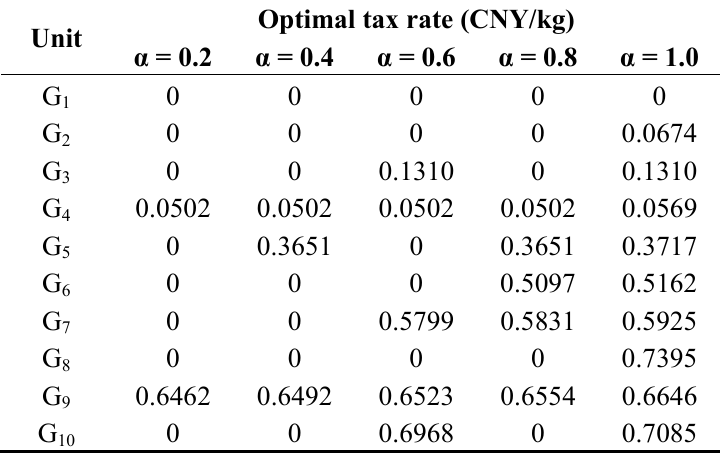
Table 4. Optimal tax rate under different permitted emission